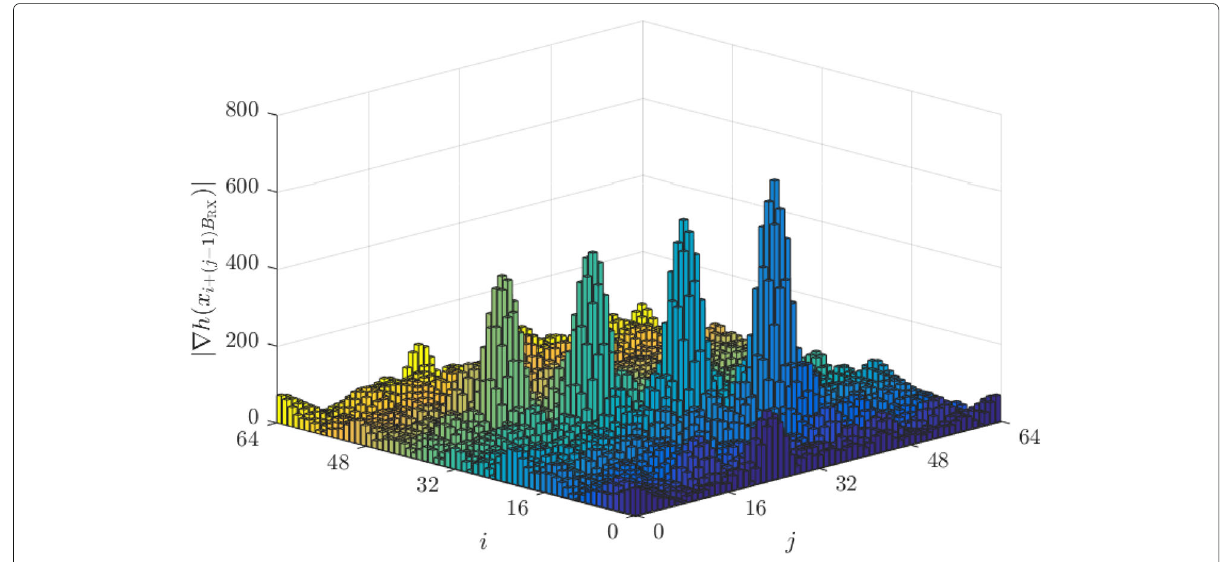
Fig. 2 The magnitude of unvec ( ∇ h ( x )) ∈ C B RX × B TX at x = 0 B , namely, before hard thresholding